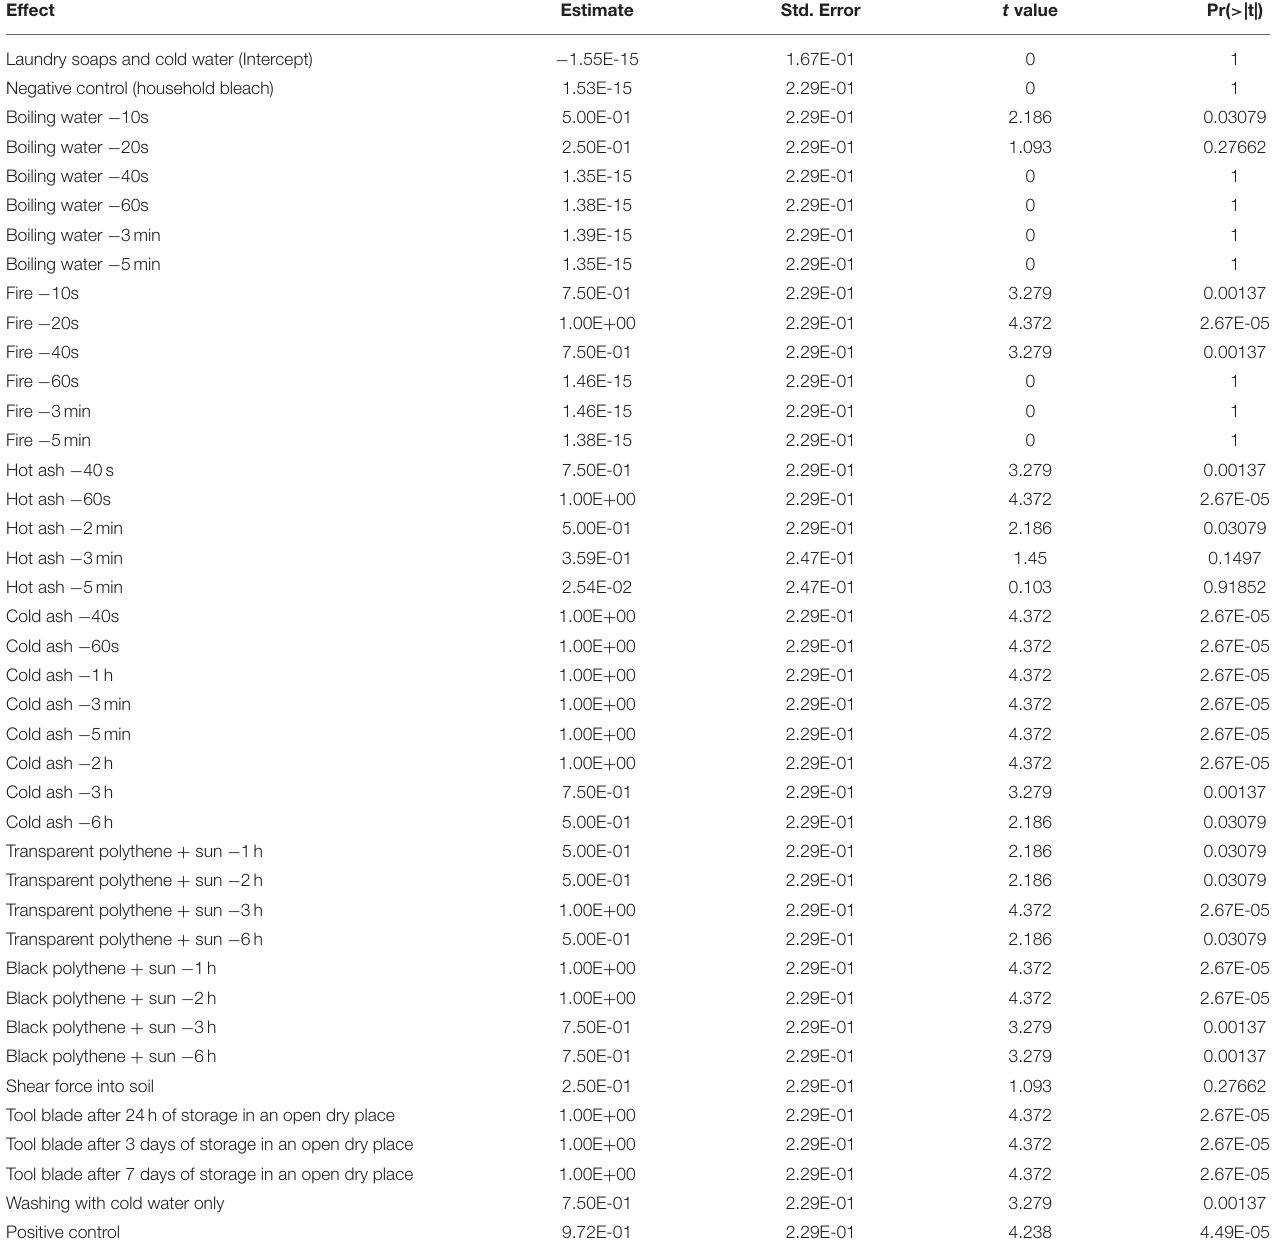
TABLE 2 | Fixed effects of different methods of tool sterilization on the percentage (%) of tool blades with Xanthomonas vasicola pv. musacearum